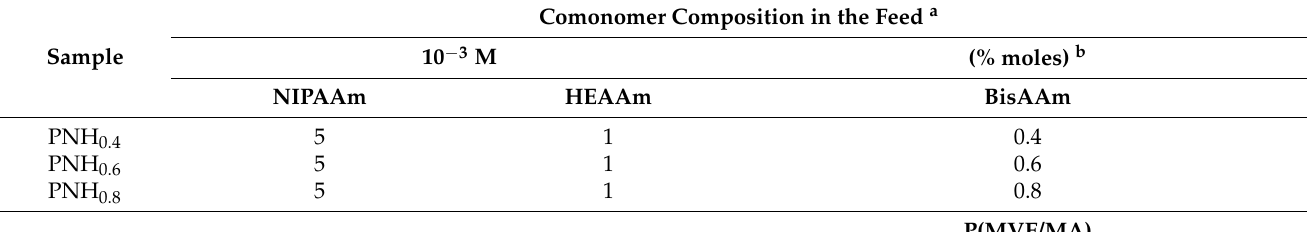
Table 1. Composition of the initial reaction mixture and of DC hydrogels.